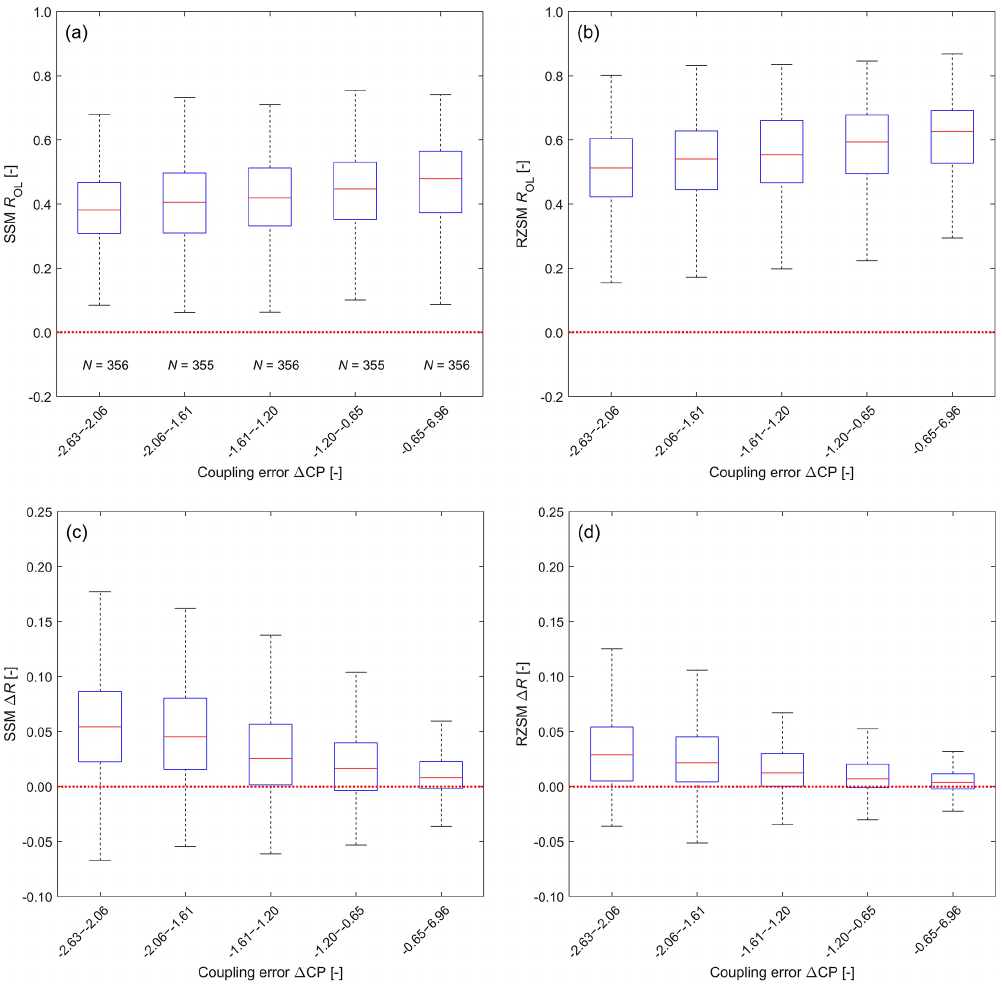
Figure 9. As in Fig. 7 but for R OL and (cid:49)R as a function of SSM–RZSM coupling error indicated by the CP difference ( (cid:49) CP = CP OL − CP obs